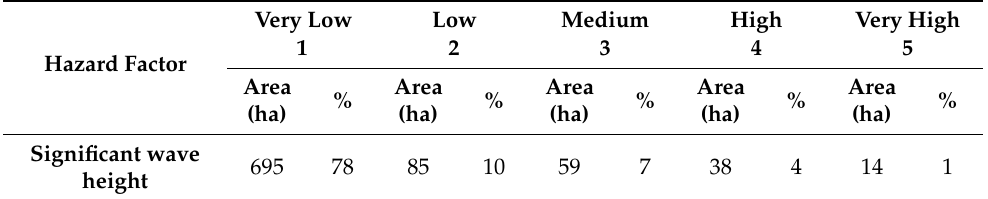
Table 25. Areas and percentages of the study area classified as each class of the significant wave weight hazard sub-factor.